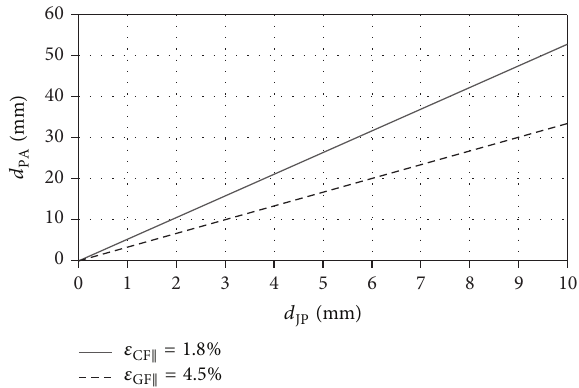
Figure 7: Required diameter of the plasticizing area at the FRP joint depending on the joining point diameter.